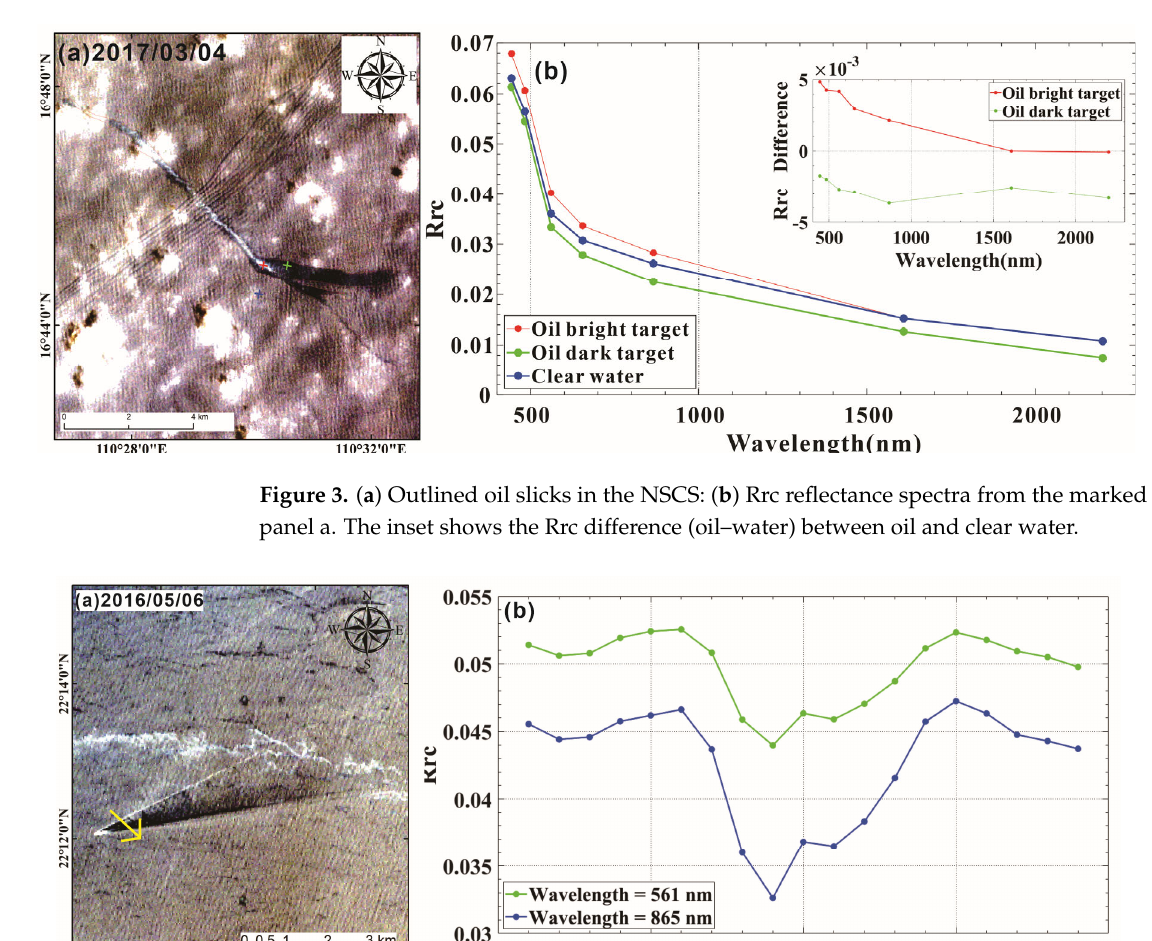
Figure 3. ( a ) Outlined oil slicks in the NSCS: ( b ) Rrc reflectance spectra from the marked points in panel a. The inset shows the Rrc difference (oil–water) between oil and clear water.